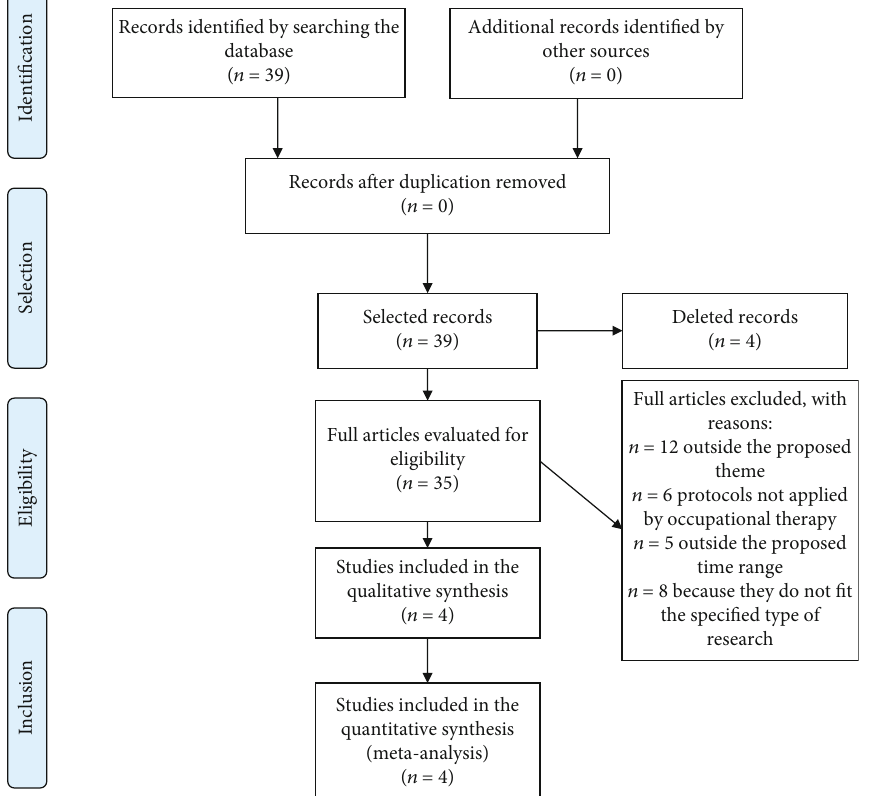
Figure 1: Research fl owchart according to PRISMA